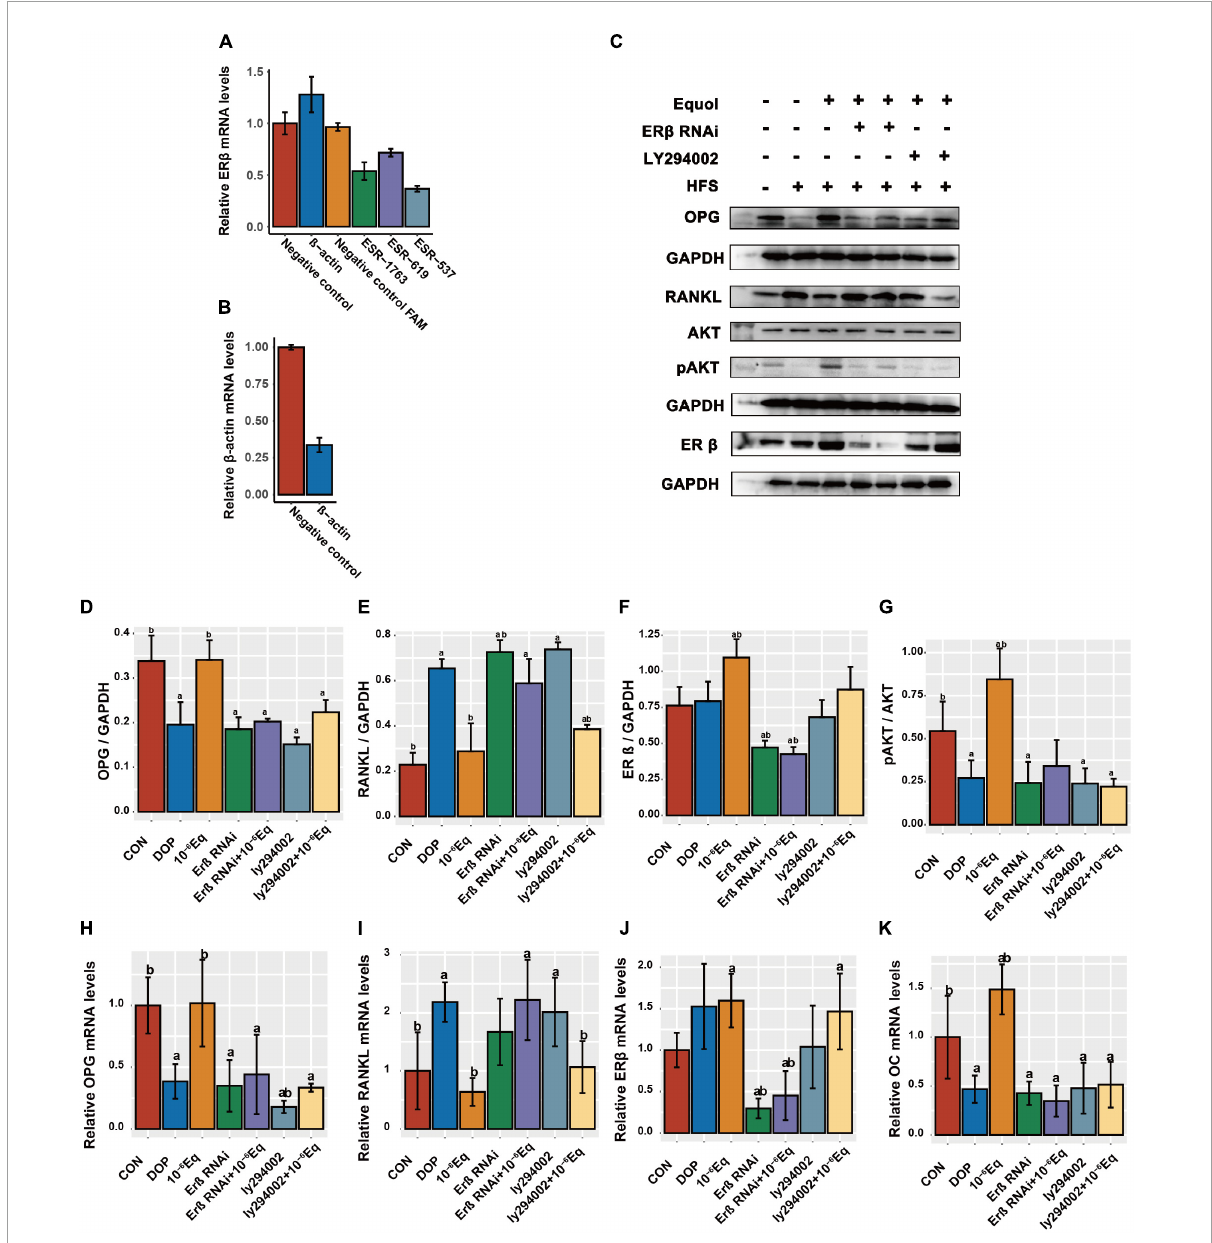
FIGURE8 S-Equol intervention elevated the osteoprotegerin/receptor activator of nuclear factor kappa-B ligand (OPG/RANKL) ratio in ROS17/2.8 cells via the ER β -PI3K-AKT pathway. (A) Quantitative RT-PCR was used to detect ER β expression in ROS17/2.8 after siRNA transfection; (B) transfection with β -actin siRNAs was used as a positive control. (C–G) The protein expression level of osteoprotegerin (OPG), receptor activator of nuclear factor kappa-B ligand (RANKL), estrogen receptor β (ER β ), and phosphorylated Akt (pAKT/AKT) in treated ROS17/2.8 cells were assessed using western blotting. (H–K) The amounts of mRNA of OPG, RANKL, ER β , and OC were measured using quantitative